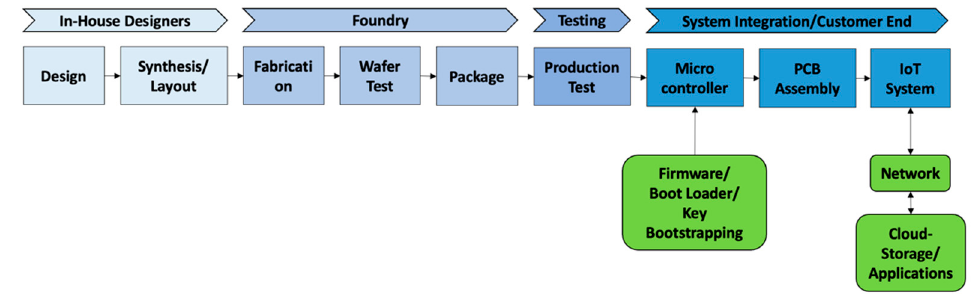
Figure 2. The different stages of hardware security.